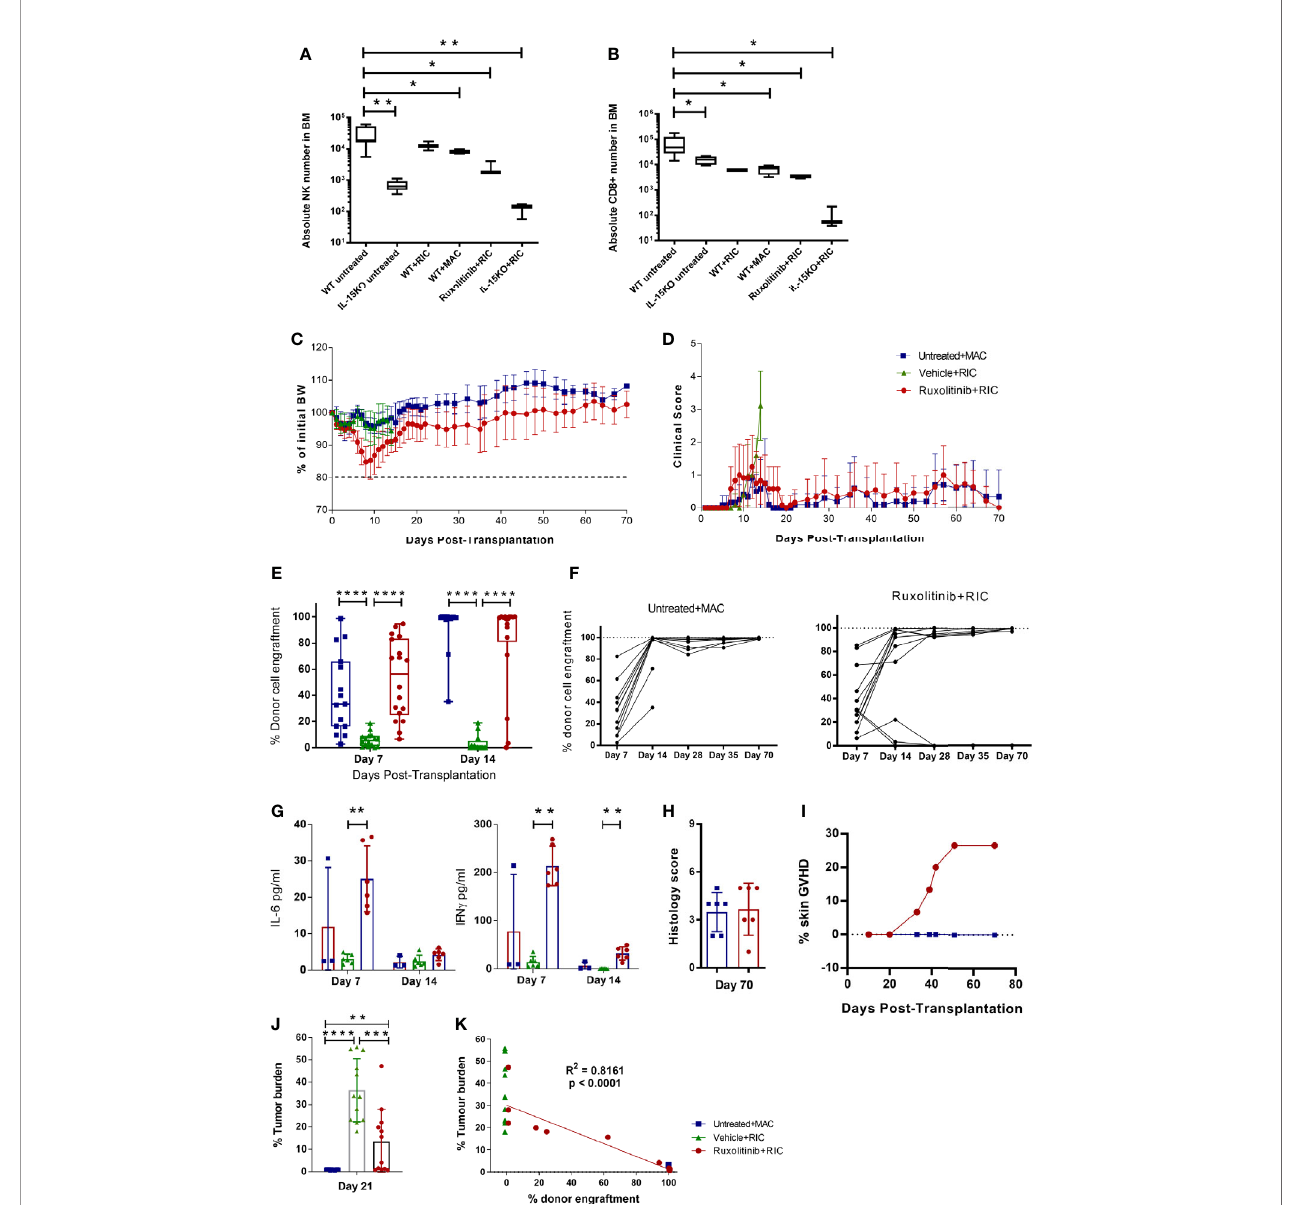
FIGURE 2 | Ruxolitinib treatment in combination with RIC mediates rapid and long-term donor cell engraftment, and permits GVT responses. Untreated WT and IL- 15KO mice were compared to WT mice treated with RIC or MAC; or WT mice treated with ruxolitinib prior to RIC, or IL-15 KO mice treated with RIC. Mice were killed four days after receiving irradiation, and the absolute number of (A) NK cells (NKp46+CD49b+) and (B) CD8 (CD3+CD8+) T cells in BM were compared between different cohorts of mice (n=3-9/group). C57BL/6 WT mice were treated with ruxolitinib or vehicle for two days, and the following day treated with RIC and alloSCT. Another cohort of untreated WT mice was treated with MAC and alloSCT. Mice were monitored for (C) body weight and (D) clinical scores up to 70 days post alloSCT. (E, F) Donor cell engraftment (H2Kd+ cells) was monitored on days 7, 14, 28, 35 and 70 post-alloSCT in blood samples (n= 18, data combined from 3 independent experiments). (G) Plasma cytokine concentration of IFN g and IL-6 was measured in blood samples collected on days 7 and 14 post-alloSCT. (H) Mice were killed 70 days post-alloSCT, and GVHD histology was conducted on gut tissue. (I) Incidence of development of skin GVHD in ruxolitinib+RIC mice compared to untreated+MAC alloSCT recipients (n=15). Mice were injected i.v. with MLL-AF9 tumour cells, and 8 days later were treated with ruxolitinib or vehicle for two days, and the following day treated with RIC and alloSCT. Another cohort of untreated WT mice was treated with MAC and alloSCT (n=12/treatment group, data combined from 2 independent experiments). (J) Mice were killed 21 days after alloSCT, and tumour burden was measured as a percentage of MLL-AF9+ cells in the BM. (K) Tumour burden was compared to donor cell engraftment between the untreated+MAC, vehicle+RIC and ruxolitinib+RIC cohorts 21 days after alloSCT. R 2 value indicates the correlation between tumour burden and donor cell engraftment in ruxolitinib+RIC alloSCT recipients. Statistical analysis was performed using Ordinary One-way Anova Holm-Sidak ’ s multiple comparisons test (A, B) , Mann-Whitney unpaired T test (E – J) , and Pearson ’ s Correlation coef fi cient (K) . *p < 0.05, **p < 0.01, ***p < 0.001, **** p <